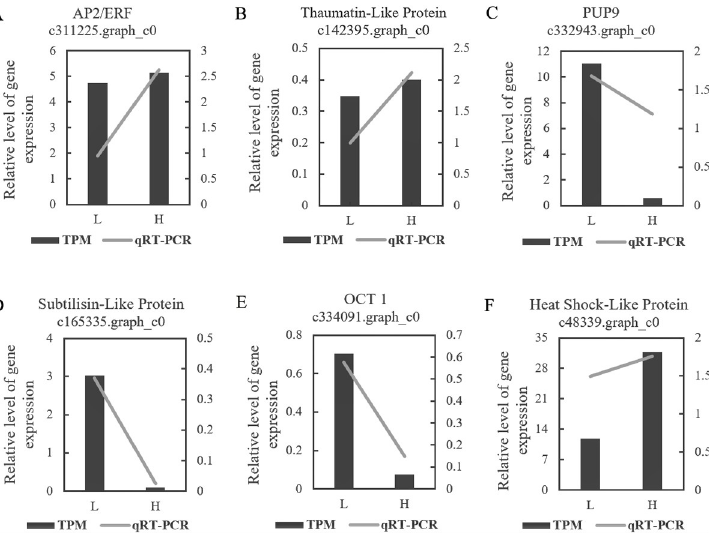
Fig 9. qRT-PCR validation of candidate genes associated with oleoresin yield and growth traits. The column shows the results of RNA-seq, and the connecting line shows the results of